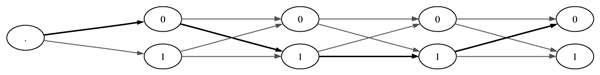
A Markov model over haplotypes. The highlighted path encodes the haplotype "0110".